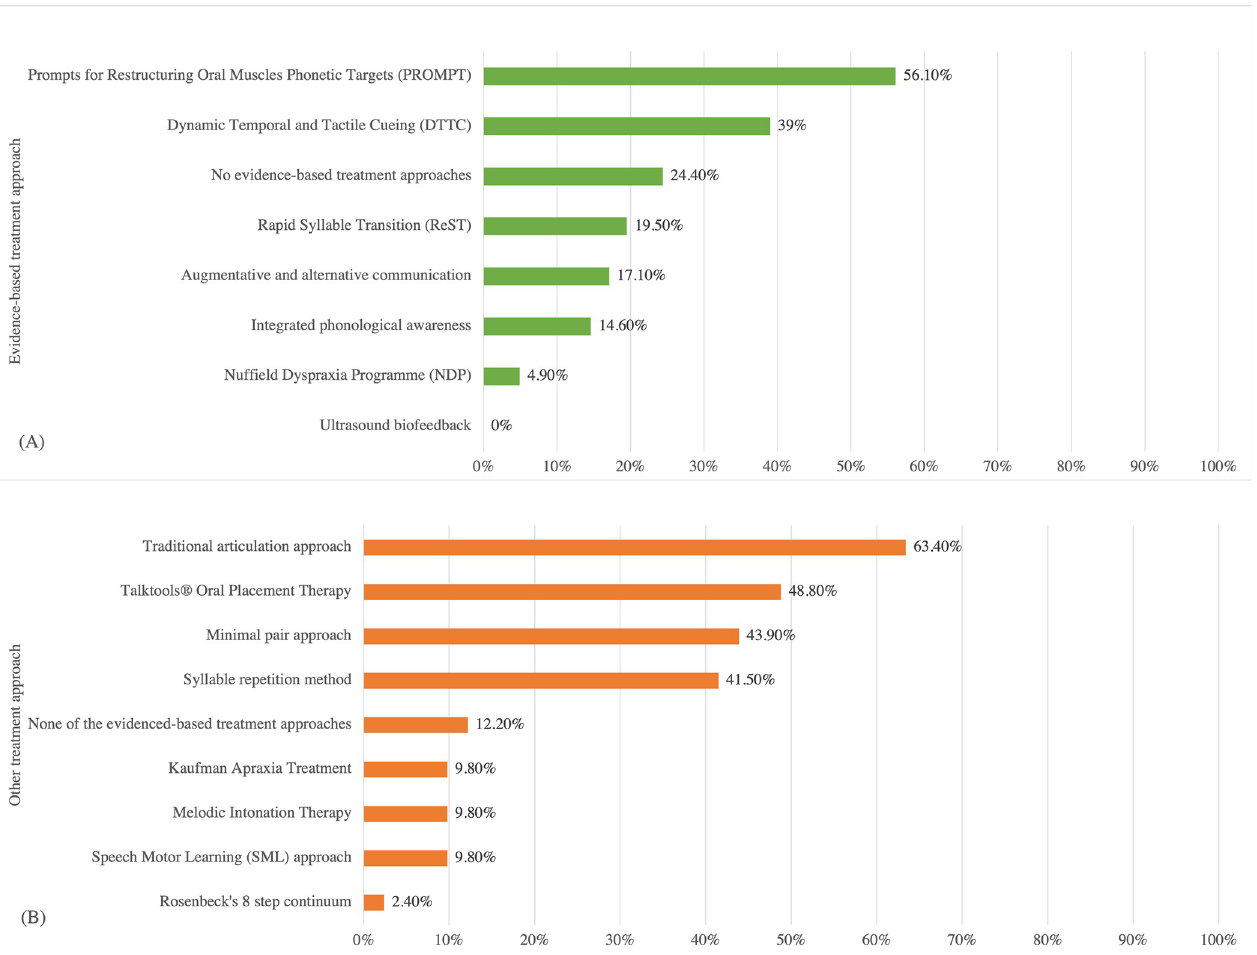
Fig 9. Respondents’ use of evidence-based and other treatment approaches for children with childhood apraxia of speech. (A) Distribution of evidenced- based treatment used by the respondents. (B) Distribution of other treatment approaches used by the respondents.